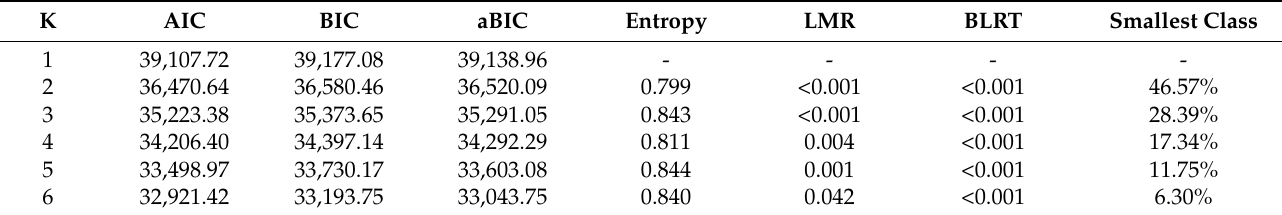
Table 1. Model fit statistics for latent profile analysis on parenting ( n =